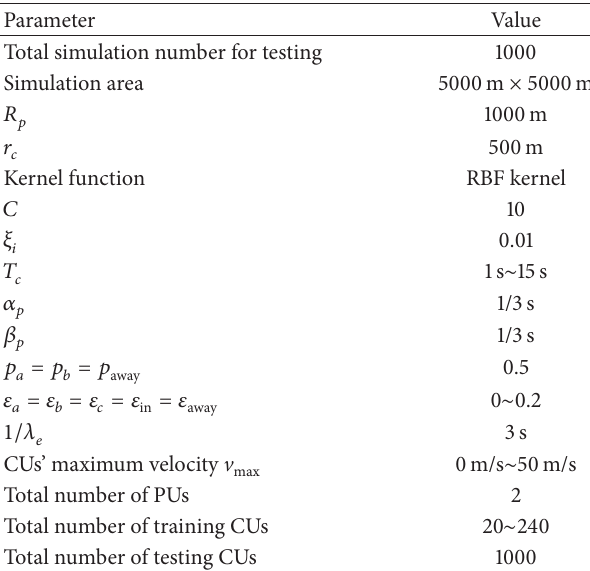
Table 1: Simulation